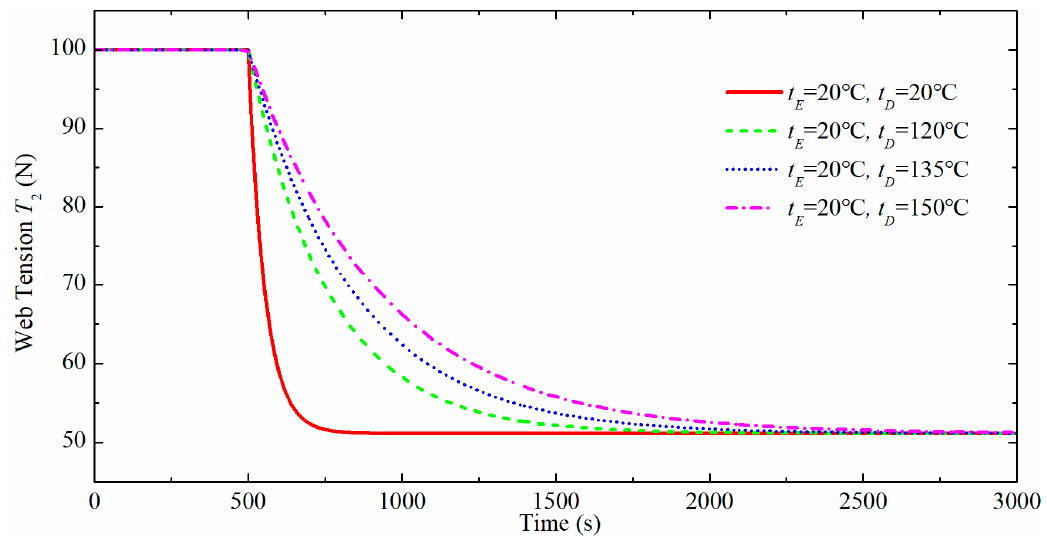
( ) T t as ( ) v t has step changes at different drying 2 1